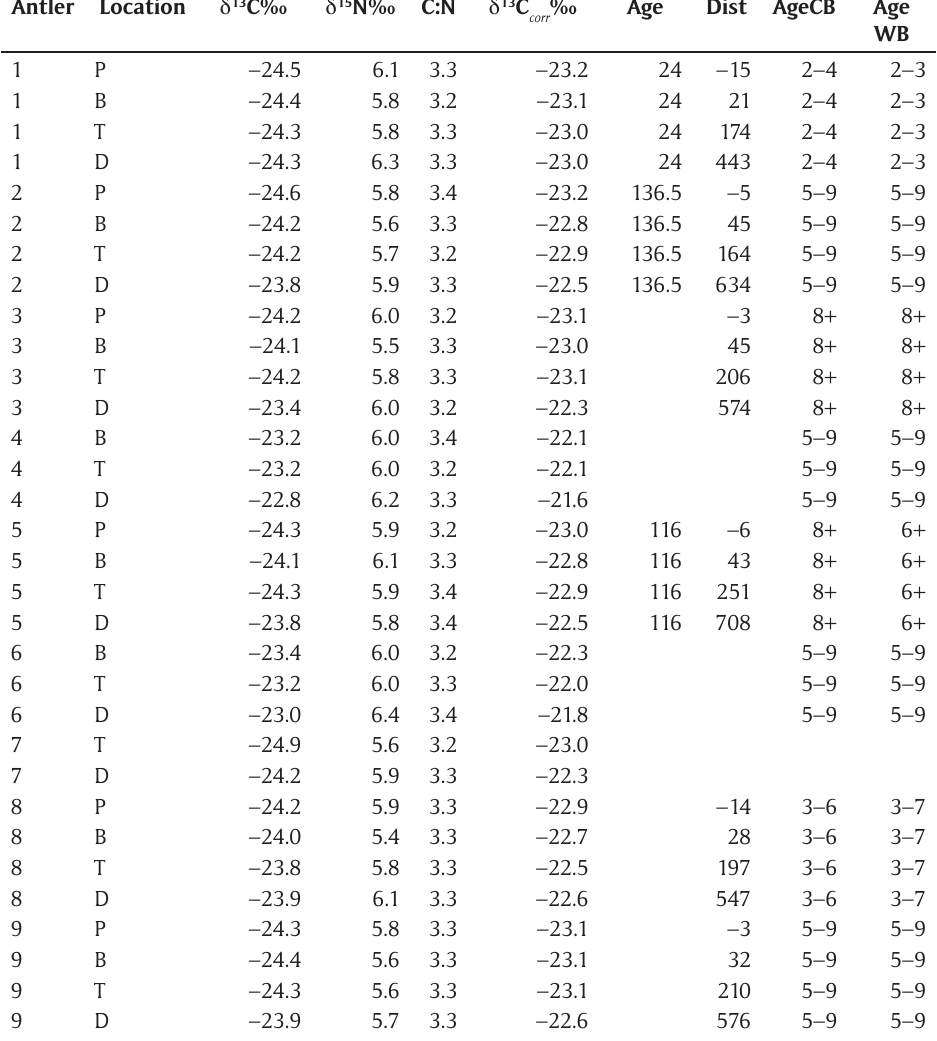
Table 1: Modern antler samples: isotope and measurement